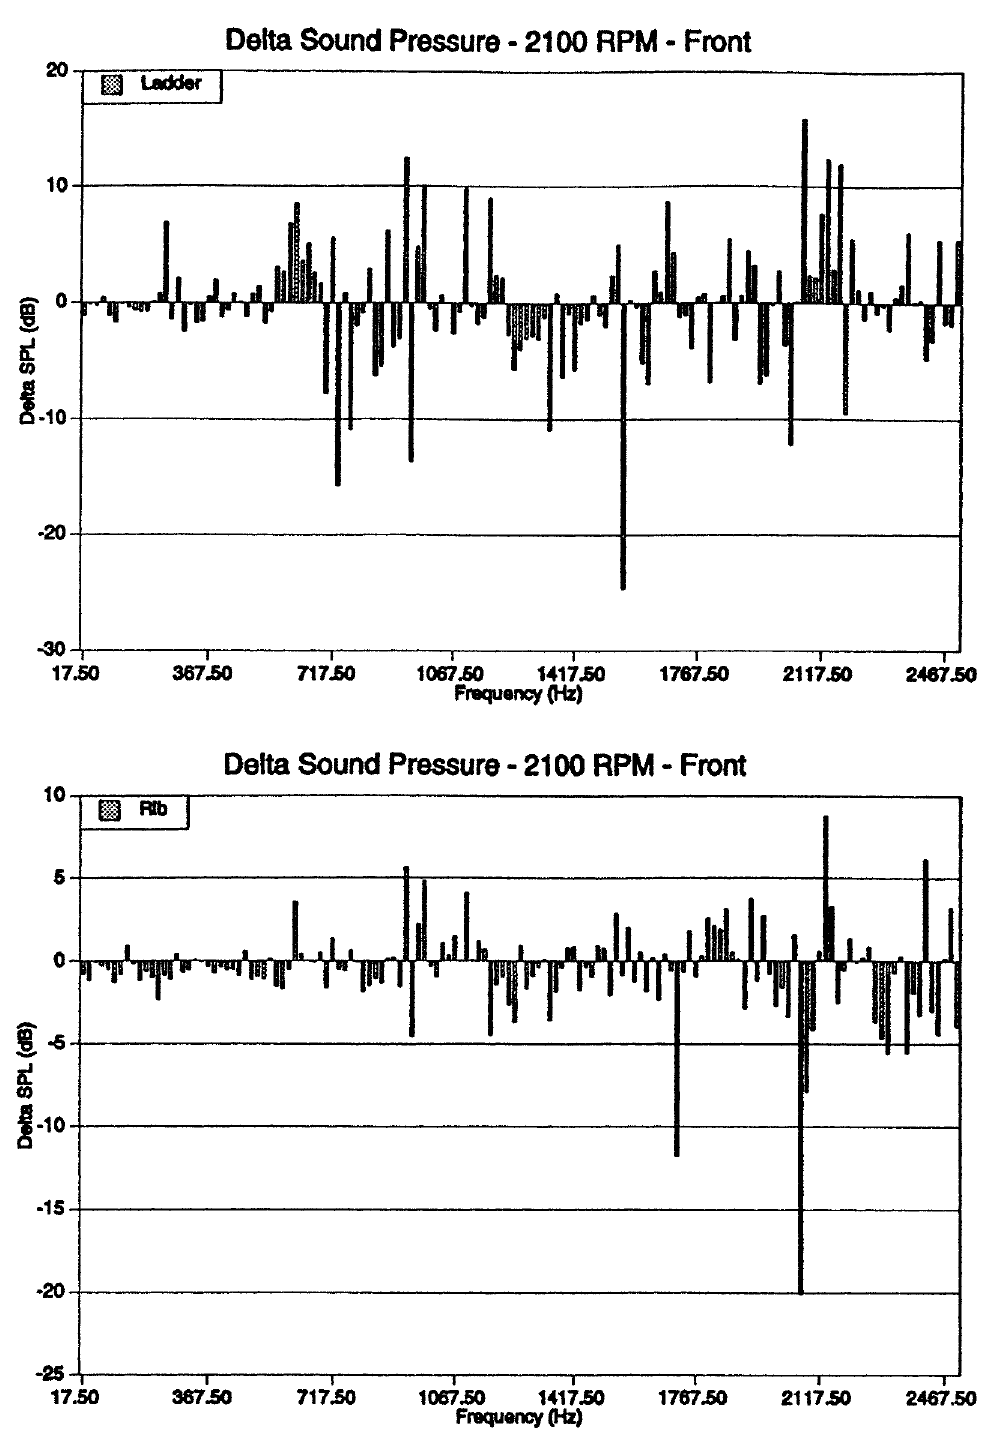
Fig. 10. Change in the acoustic response in the front of the